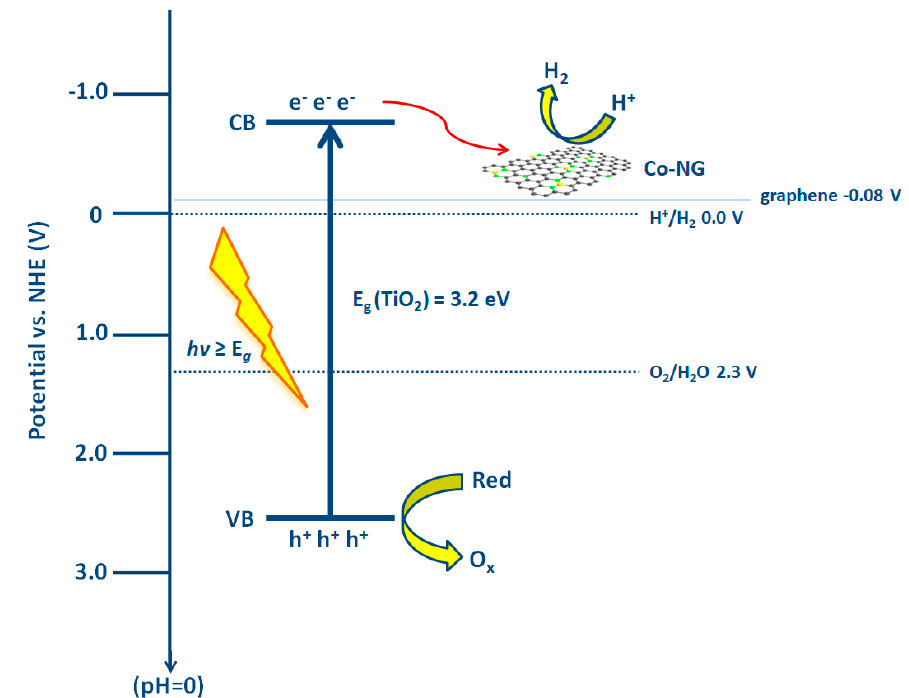
Figure 14. Schematic diagram of proposed photocatalytic mechanism in the CO-NG/TiO 2